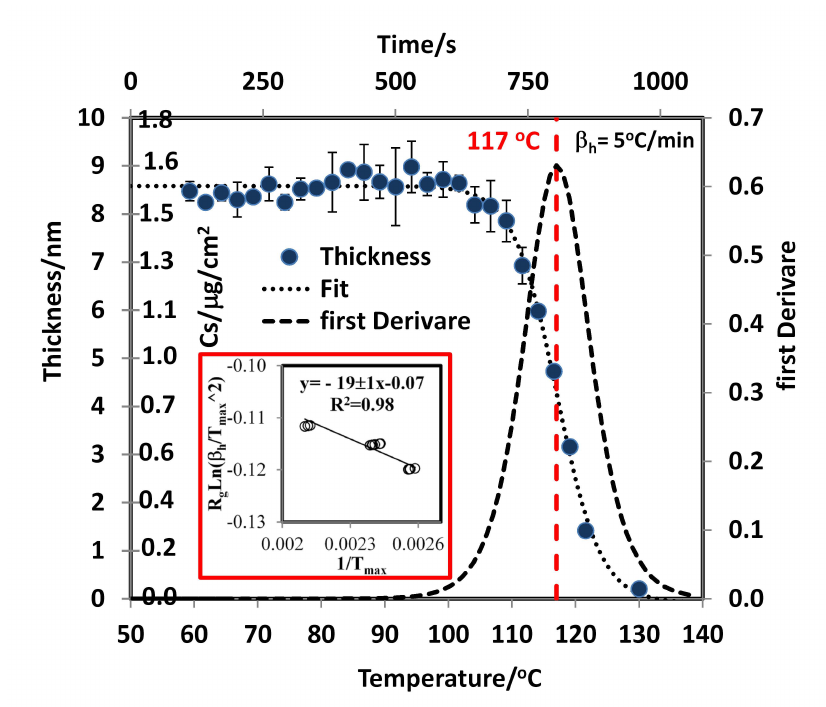
Figure 6. Plot of thickness vs. T( ◦ C) from TPM-TDS and d( ∆ R/R)/dT vs. T.